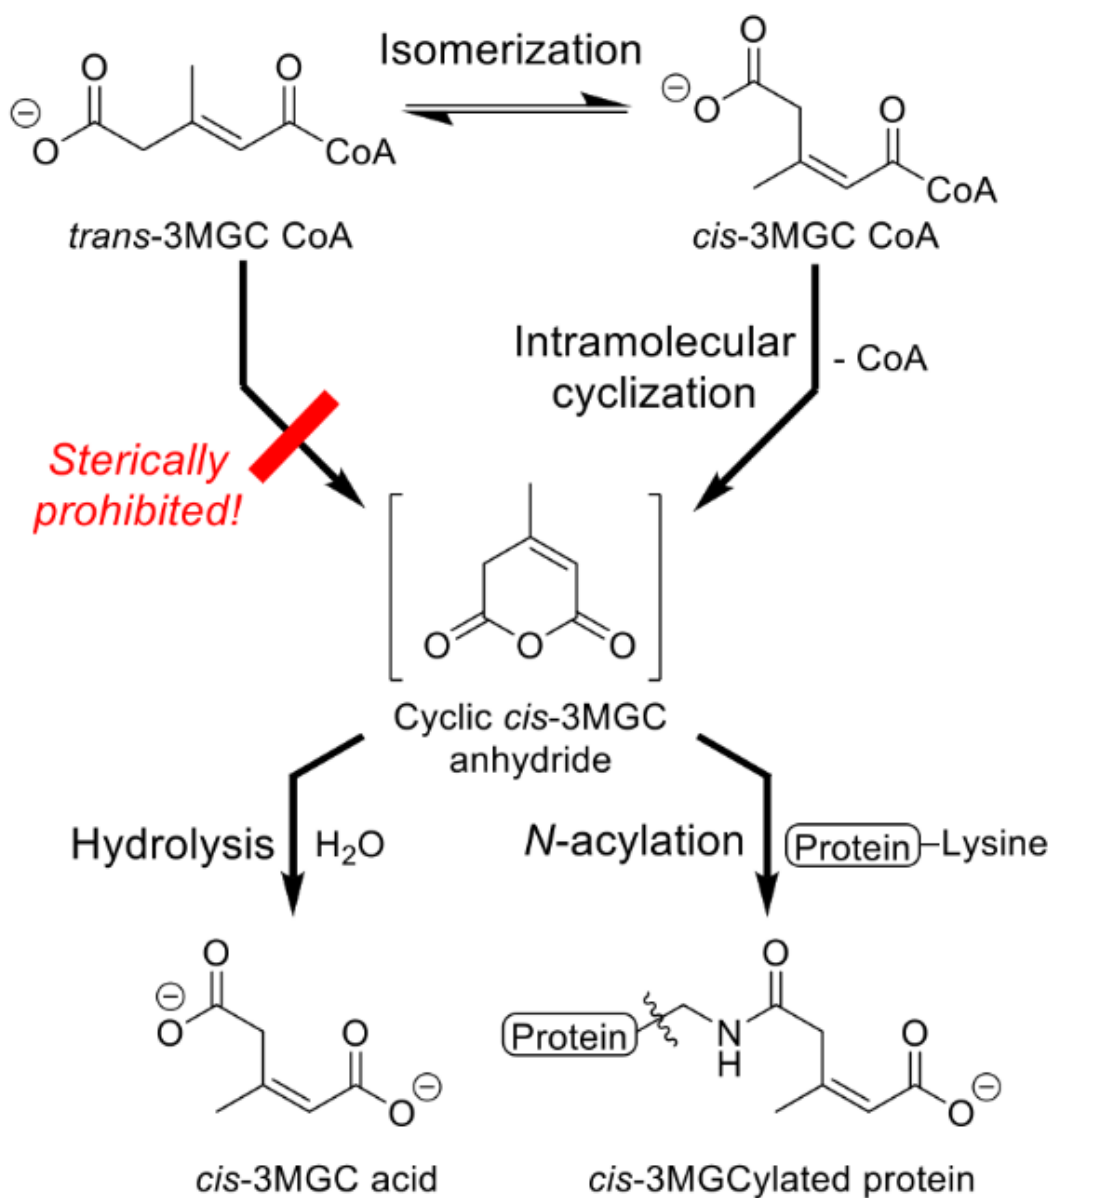
Figure 4. Non ‐ enzymatic reactions downstream of tran s ‐ 3MGC CoA. Once formed, trans ‐ 3MGC CoA can readily isomerize to cis ‐ 3MGC CoA. A key difference between these diastereomers is the ability of cis ‐ 3MGC CoA, but not trans ‐ 3MGC CoA, to undergo intramolecular cyclization,